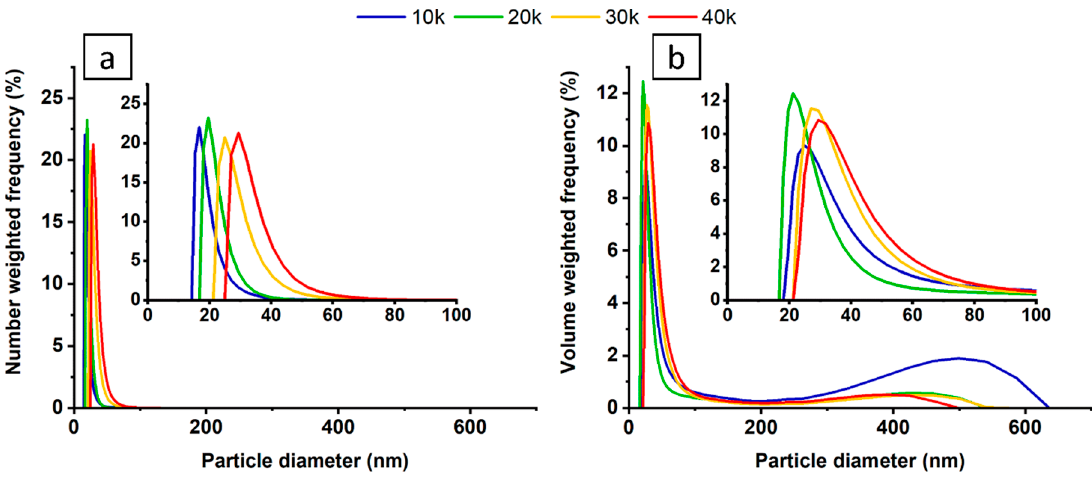
Figure 1. Relative frequency number ( a ) and volume ( b ) weighted by the nanoparticle size distribution for colloids varying in the number of applied laser pulses.